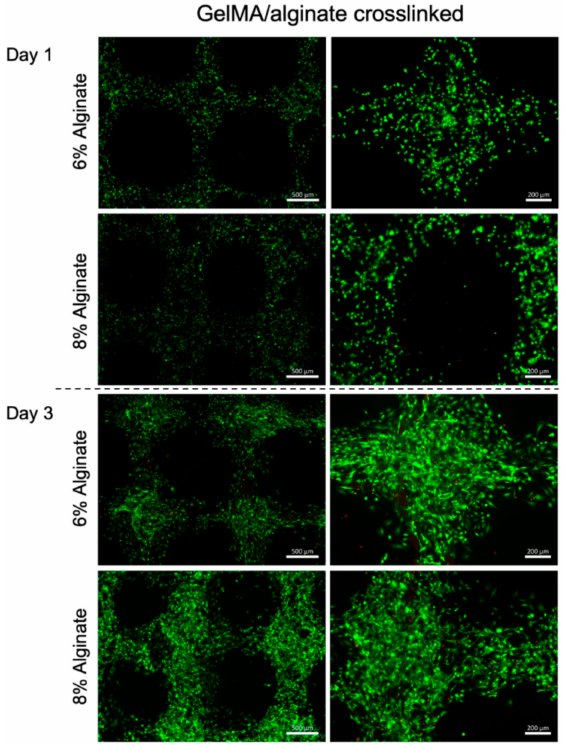
Figure 3. Live / Dead cell staining of C2C12 printed in GelMA hydrogel with alginate concentrations 6% and 8% (w / v) crosslinked with UV light and CaCl 2 crosslinking. Images were taken on days 1 and 3 after bioprinting. Green color represents healthy cells and red color represents dead